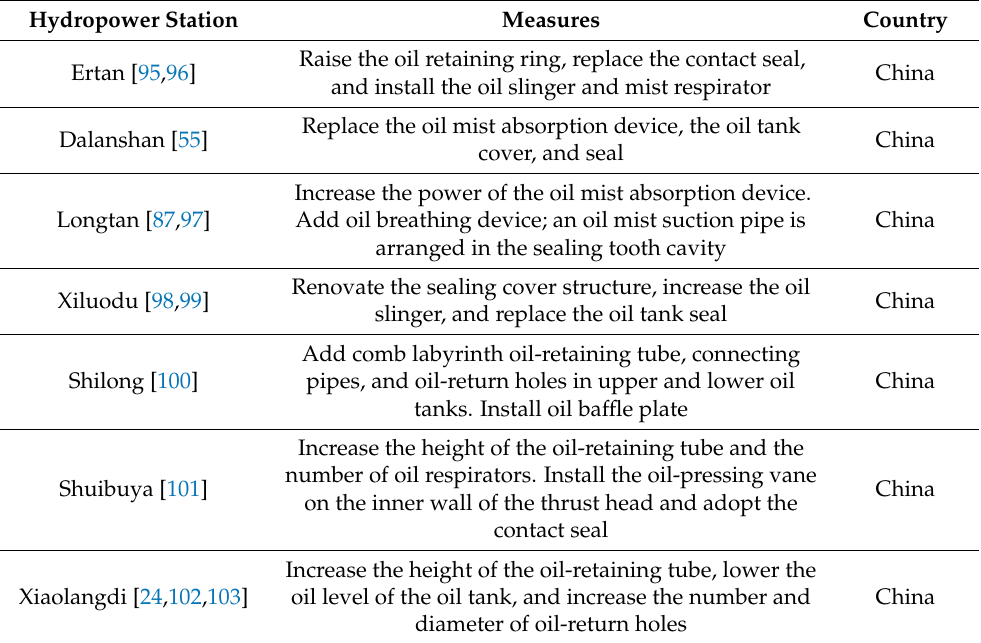
Table 2. Comprehensive measures for oil mist leakage